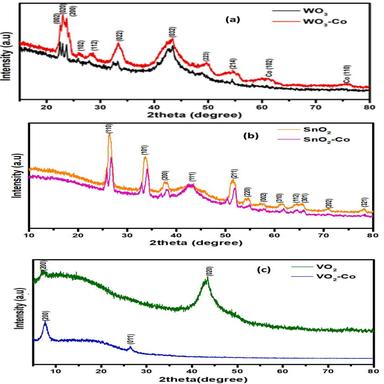
The X-Ray Diffraction pattern of WO3, WO3-Co, SnO2, SnO2-Co, VO2, and VO2-Co. (For interpretation of the references to colour in this figure legend, the reader is referred to the web version of this article.)